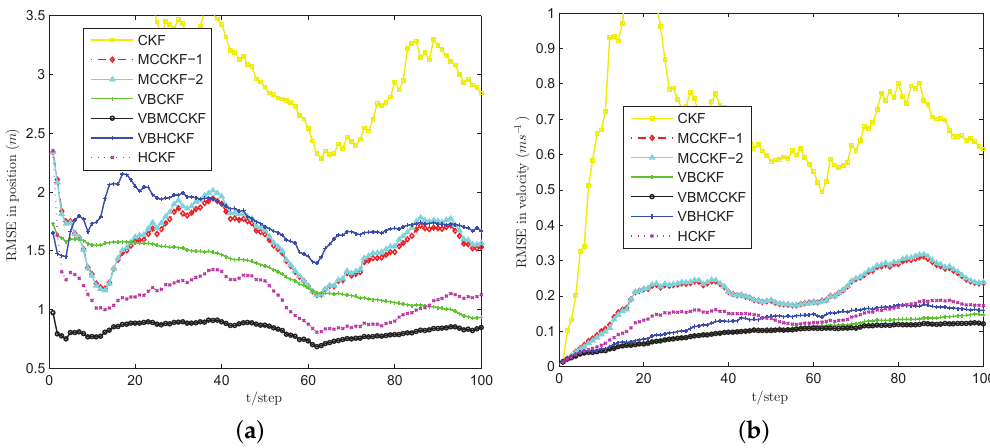
Figure 6. RMSE performances of different filters under Case E. ( a ) position; ( b ) velocity. Table 1. ARMSEs of different filters under five